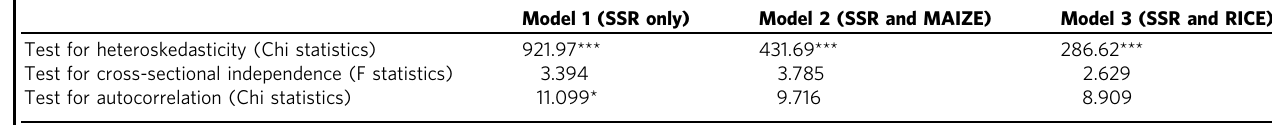
Table 10 Speci fi cation tests of panel estimation.